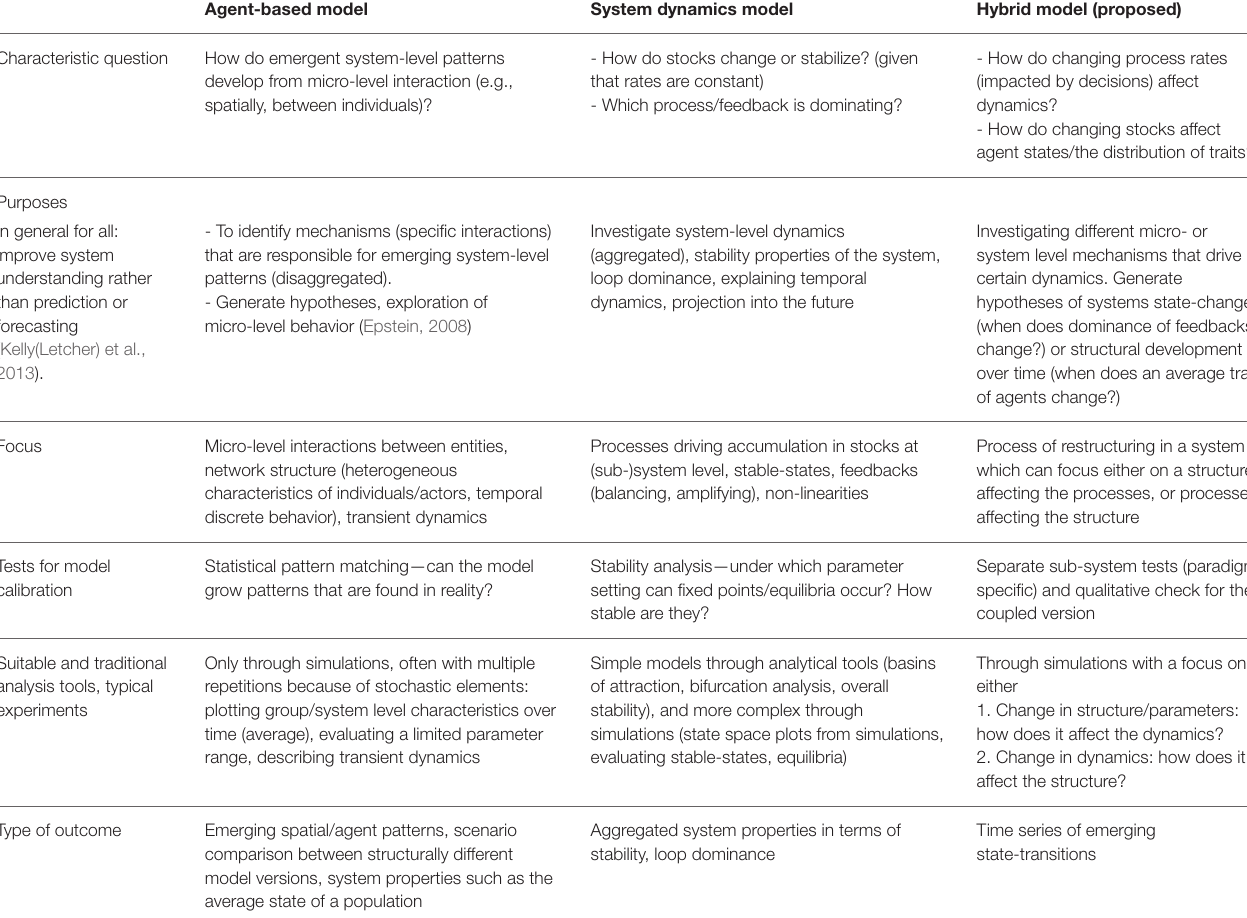
TABLE 1 | Characteristics of agent-based and system dynamics models, and how they can be combined within a fully integrated hybrid